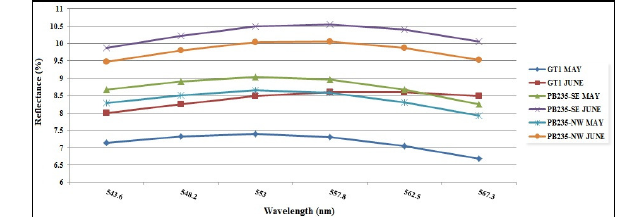
Figure 3. Spectral behaviour in leaf scale from 600 to 700nm, Figure 7. Spectral behaviour in leaf scale, for May and June, in for May and June, of the Rubber trees stands: GT1, PB235-SE the region of 550nm of the Rubber trees stands: GT1, PB235- and PB235-NW SE and PB235-NW